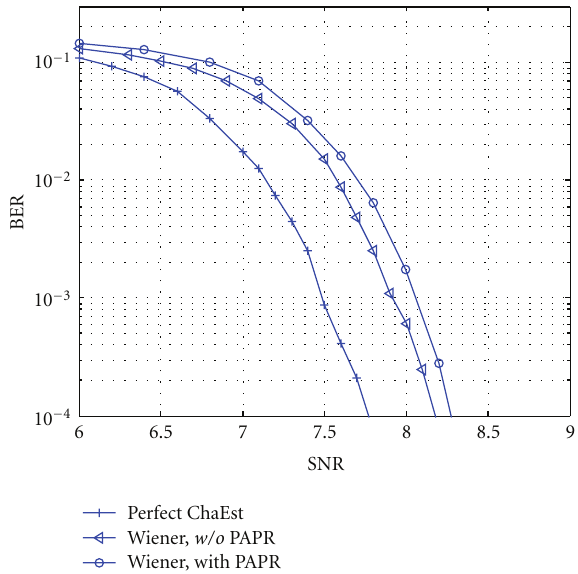
Figure 20: BER performance, 2 K mode, 16-QAM modulation, and TU6